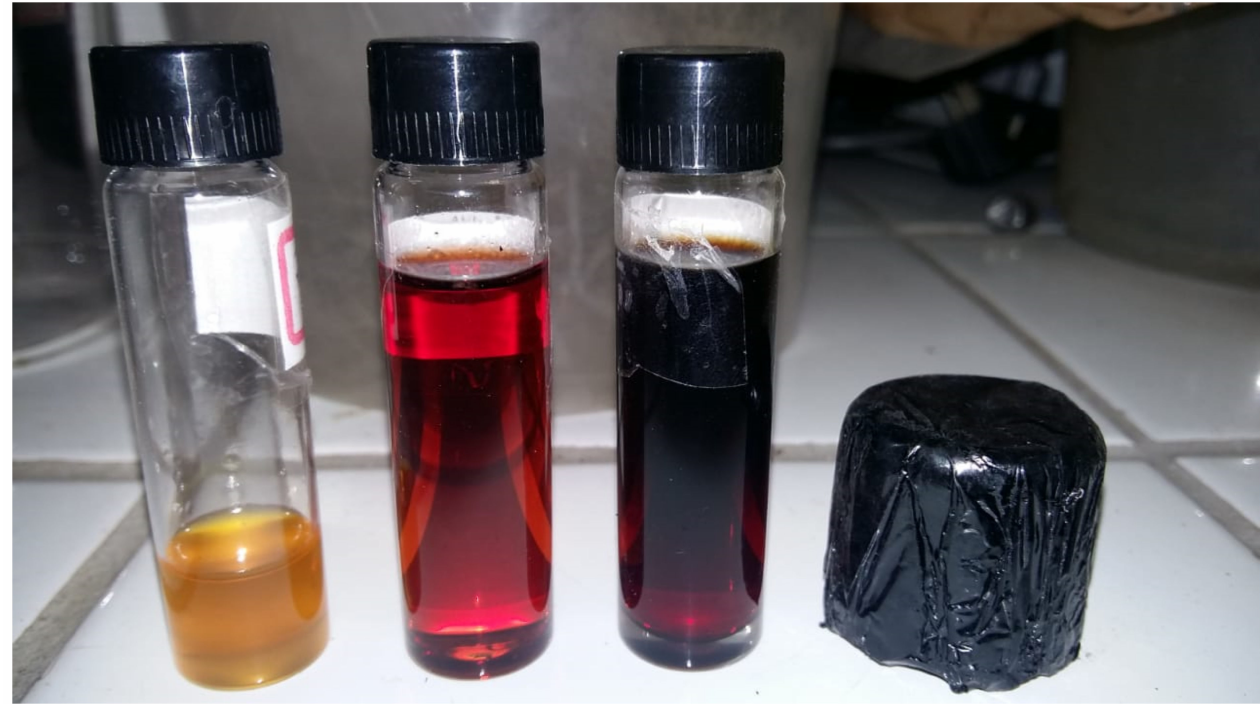
Figure 9. Distillation fractions [gasoline (yellow), light kerosene (red), and kerosene (red dark)-like boiling range temperature fossil fuels] and bottoms [Raffinate (black solid)] obtained by fractional distillation of bio-oil produced by pyrolysis of Aça í ( Euterpe oleracea, Mart.) seeds at 450 ◦ C and 1.0 atmosphere, in pilot